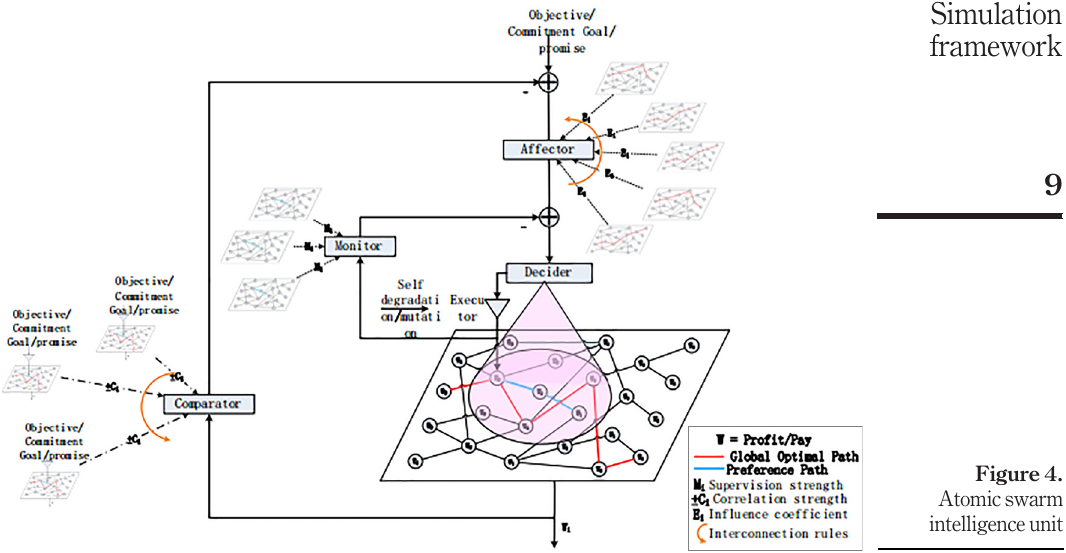
Figure 4. Atomic swarm